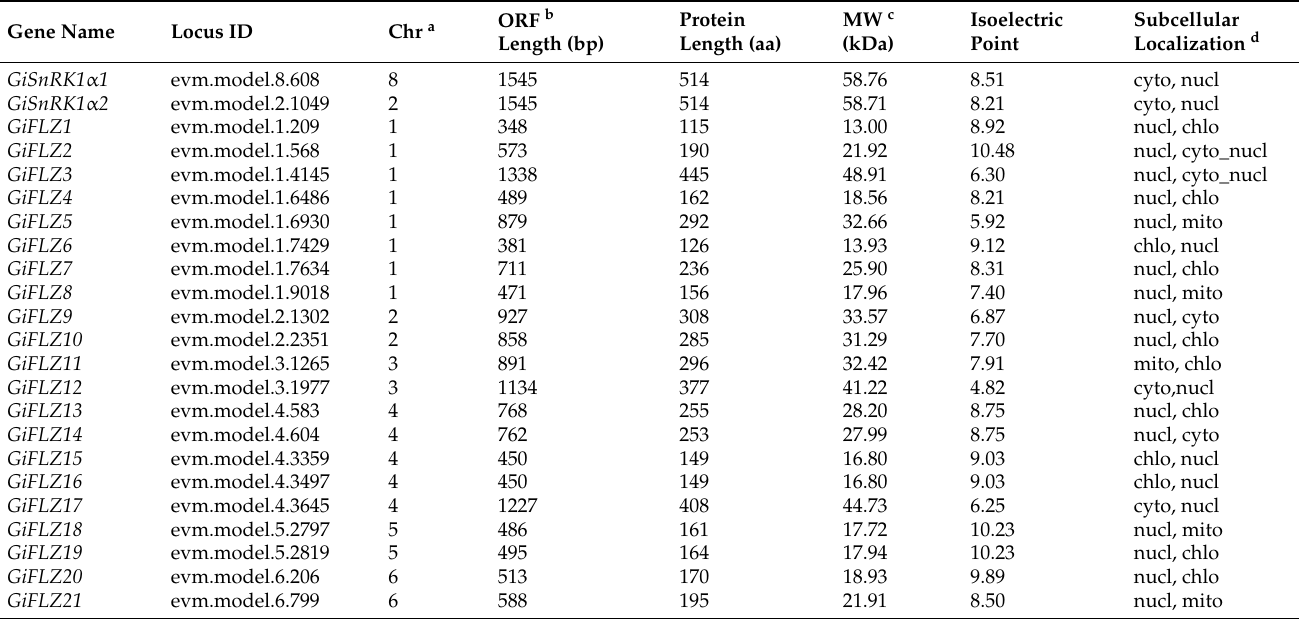
Table 1. Summary of GiSnRK1 α and GiFLZ